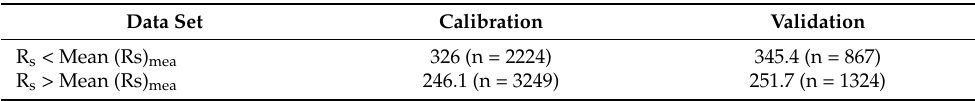
Table 10. RMSE values (J · cm − 2 · day − 1 ) and number of data points belonging to each group separated by a threshold value (mean of measured solar radiation): lower and higher than the mentioned threshold in calibration and validation